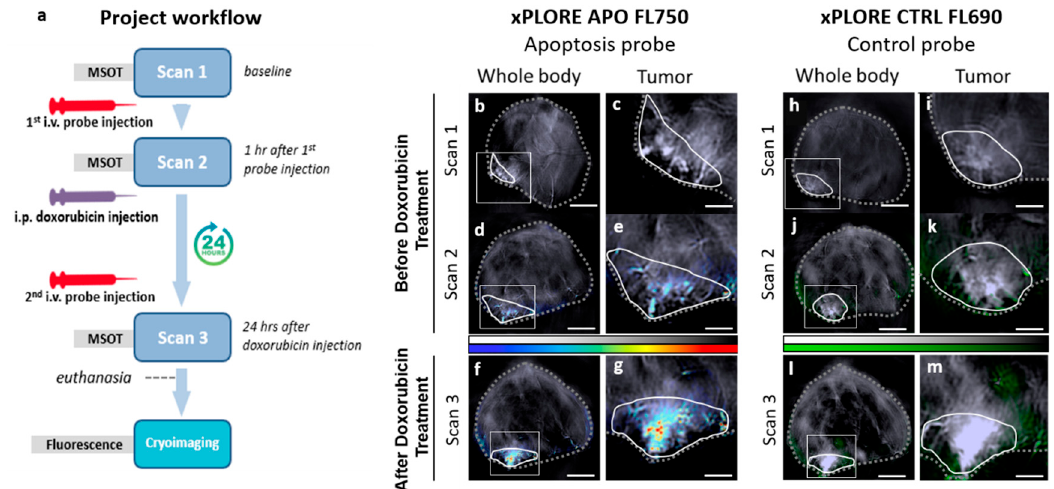
Figure 2. MSOT imaging of xPLORE-Apo-FL750 © for the assessment of tumor apoptotic responses to doxorubicin therapy. ( a ) Schematic diagram summarizing the therapeutic, MSOT imaging, and cryoimaging schemes. ( b – m ) Transverse anatomical whole body MSOT images of mice bearing 4T1 tumors were collected at 800 nm and are shown in grayscale. These anatomical images were overlaid with the signal induced by xPLORE-Apo-FL750 © (jet scale) or xPLORE-CTRL- FL690 © (green scale). Animals were imaged with MSOT prior to administration of xPLORE probes ( b , c , h , i —Scan 1), then injected with probe solution mixture and imaged again 1 h later ( d , e , j , k —Scan 2). Next, mice were treated with doxorubicin for 23 h, re-injected with the probes and imaged again 1 h later using MSOT ( f , g , l , m —Scan 3). ( b – g ) Results obtained for xPLORE-Apo-FL750©. ( h – m ) Results obtained for xPLORE-CTRL-FL690©. Insets ( c , e , g , i , k , m ) shown next to whole animal ( b , d , f , h , j , l ). MSOT images are magnified views of the corresponding tumor regions of interest.